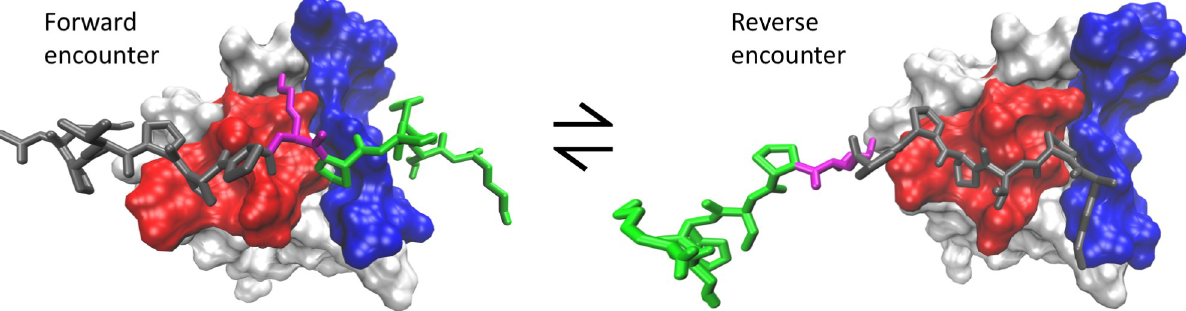
Fig 8. Forward and reverse representations of ArkA during binding. Snapshots from MD simulation showing both the forward and reverse orientations of ArkA that are possible during binding. ArkA is shown in the stick representation with seg1 in grey, seg2 in green, and K(-3) in magenta. AbpSH3 SI is shown in red and SII in blue. The double headed arrow signifies that the ArkA orientation can flip during a simulation.